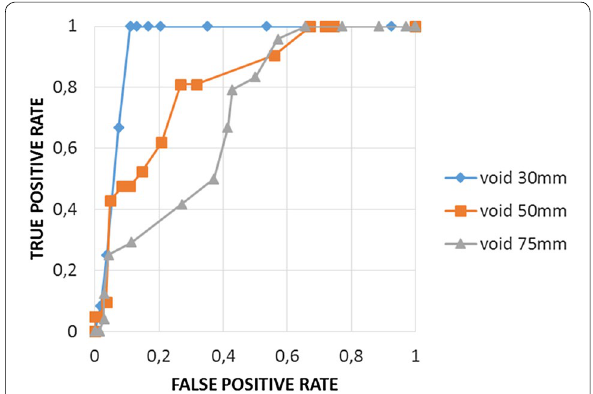
Fig. 11 ROC curve for the void type block